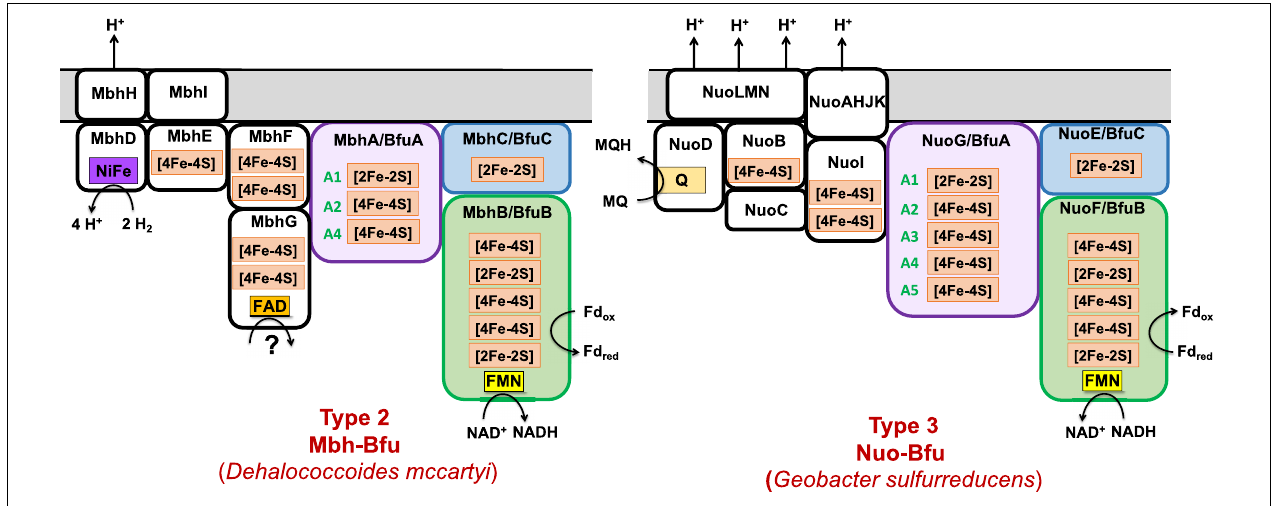
FIGURE 8 | Predicted subunits and cofactor contents of uncharacterized membrane-bound Bfu enzymes. See text for details.